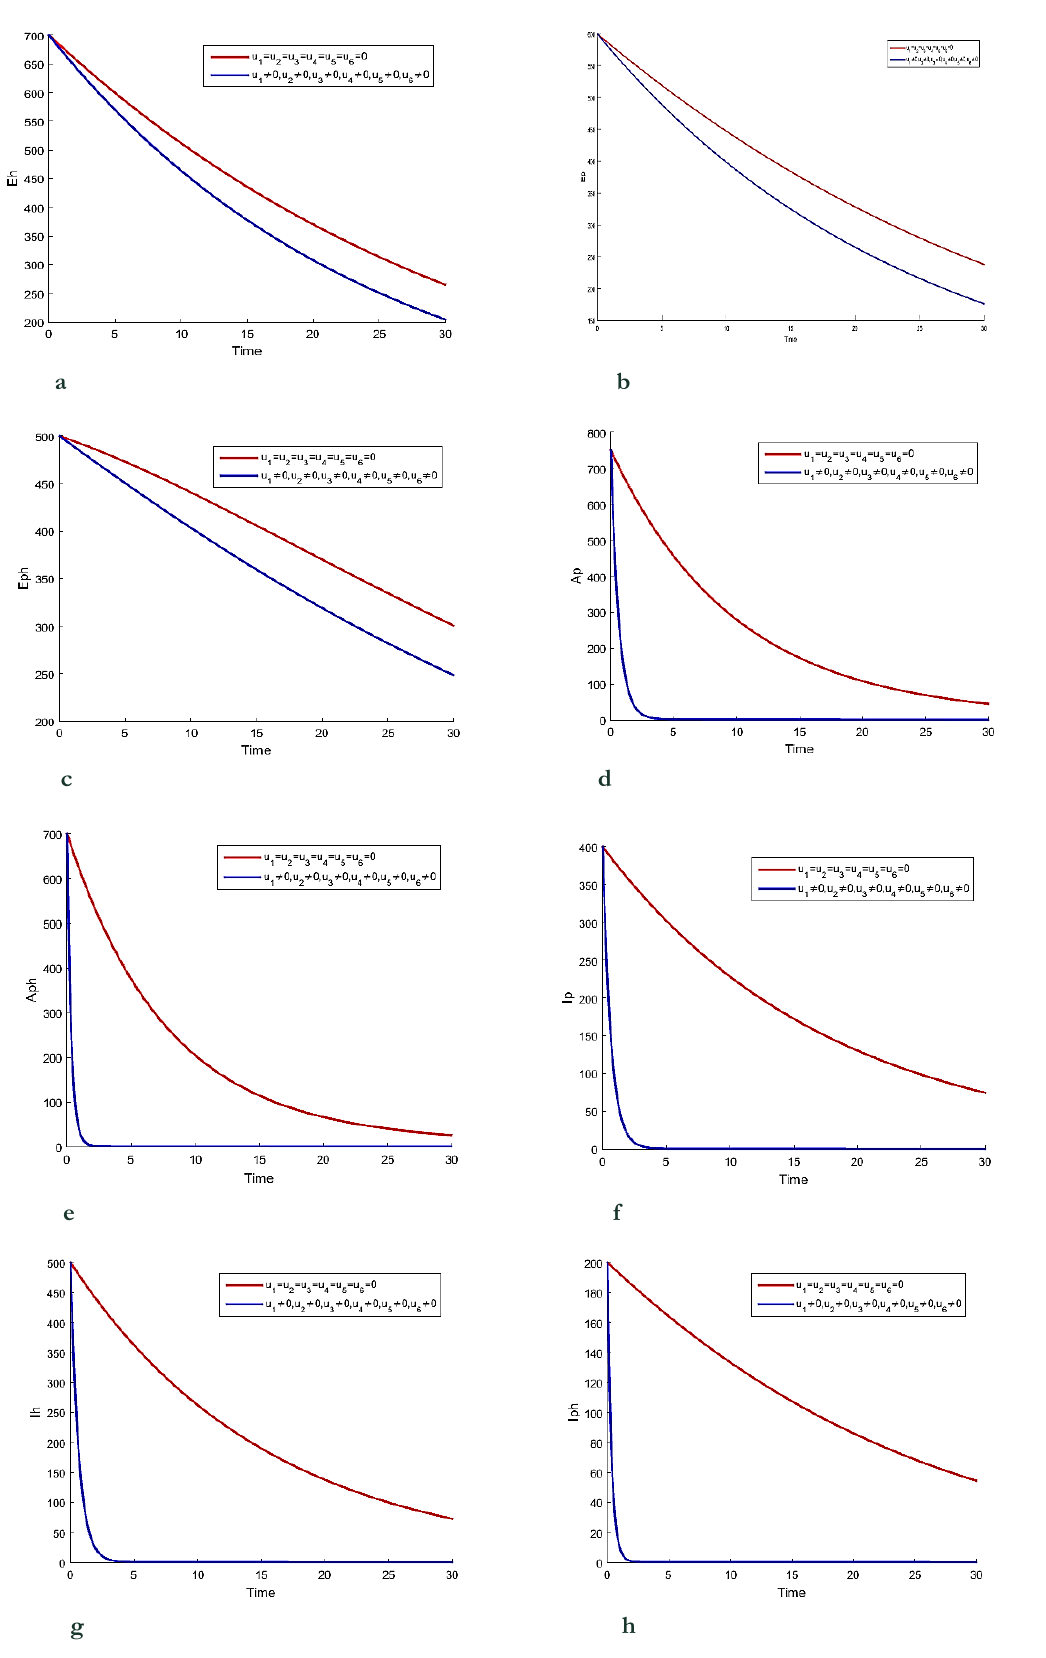
, 𝐮 , 𝐮 , 𝐮 , 𝐮 and 𝐮 𝟏 𝟐 𝟑 𝟒 𝟓